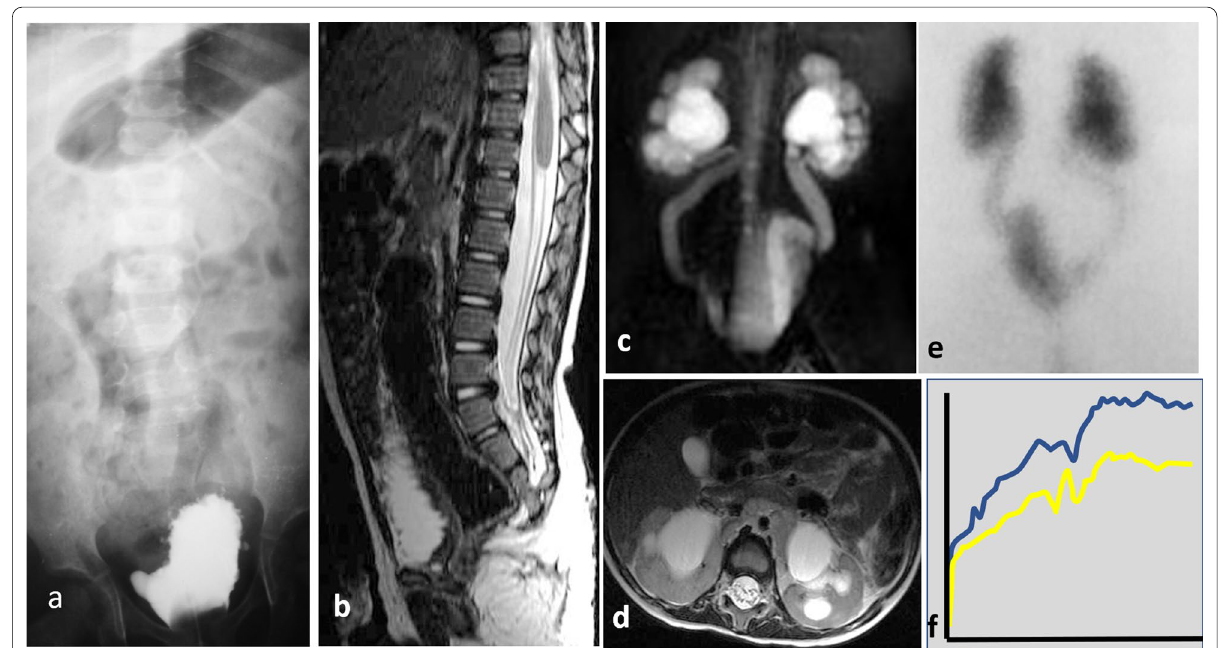
Fig. 5 4-year-old girl with history of anorectal anomaly, ultrasound revealed bilateral grade P3 hydronephrosis. a MCUG study reveals dysplastic sacrum, urinary bladder with multiple diverticulae with no evidence of reflux. b MRI sagittal spine shows evidence of caudal regression. c MRU shows bilateral hydroureter and hydronephrosis. d axial high-resolution T2WI shows dilatation of the renal pelvis, central and peripheral calyces. Renal parenchyma exhibits hyperintense signal with poor corticomedullary differentiation. e DTPA dynamic renal scintigraphy reveals retention of activity in both kidneys collecting systems and both ureters with plateau curve pattern ( f